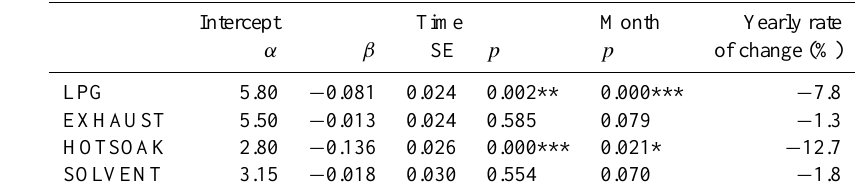
Table 4. Linear regression for all source